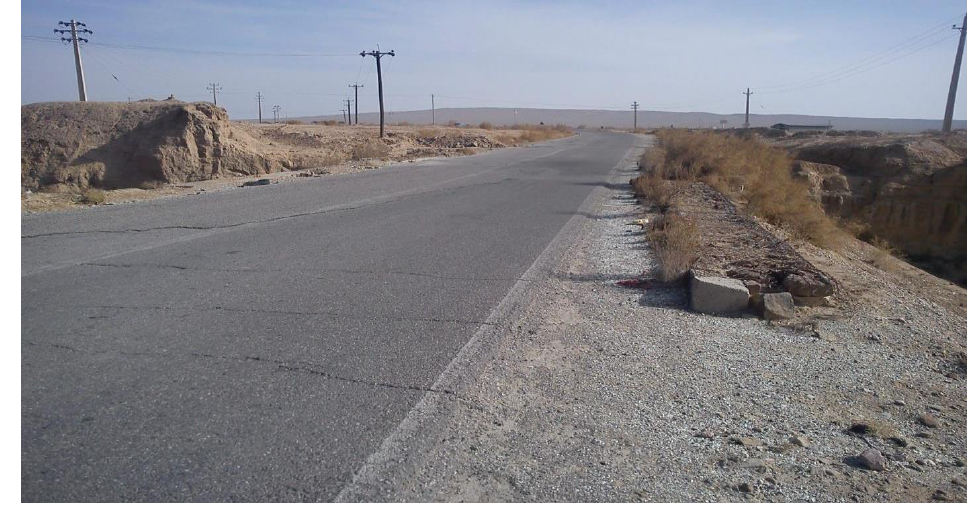
Figure 23. Distresses of pavement and safety problems in bridge No.